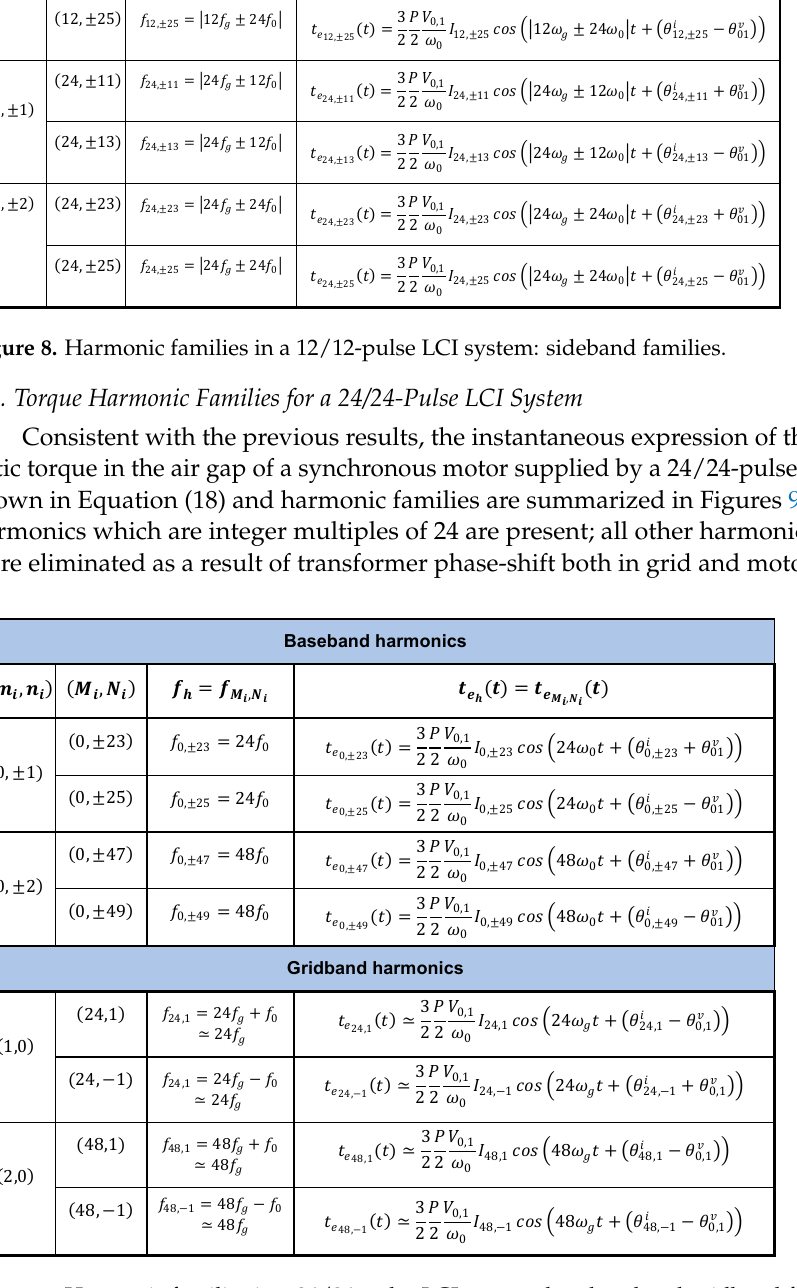
Figure 9. Harmonic families in a 24/24-pulse LCI system: baseband and gridband families.